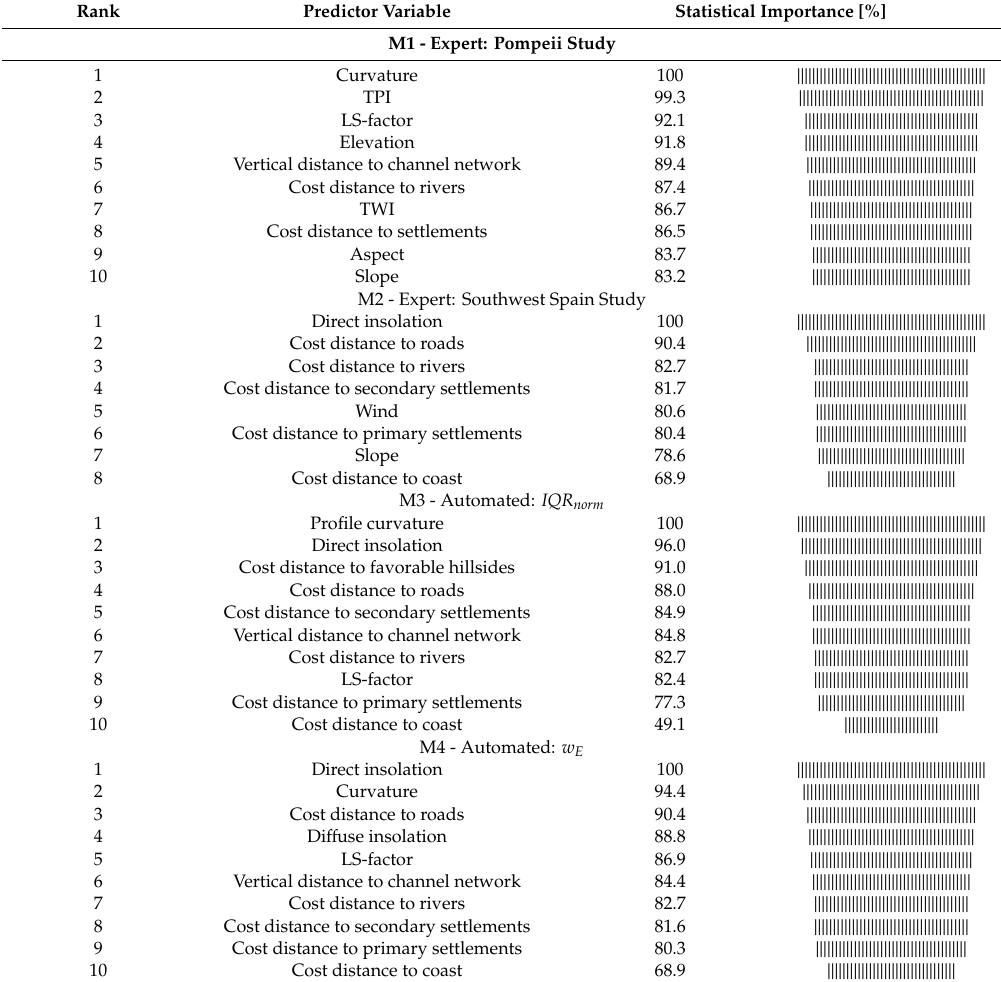
Table 2. Variable importance ranking of the predictive